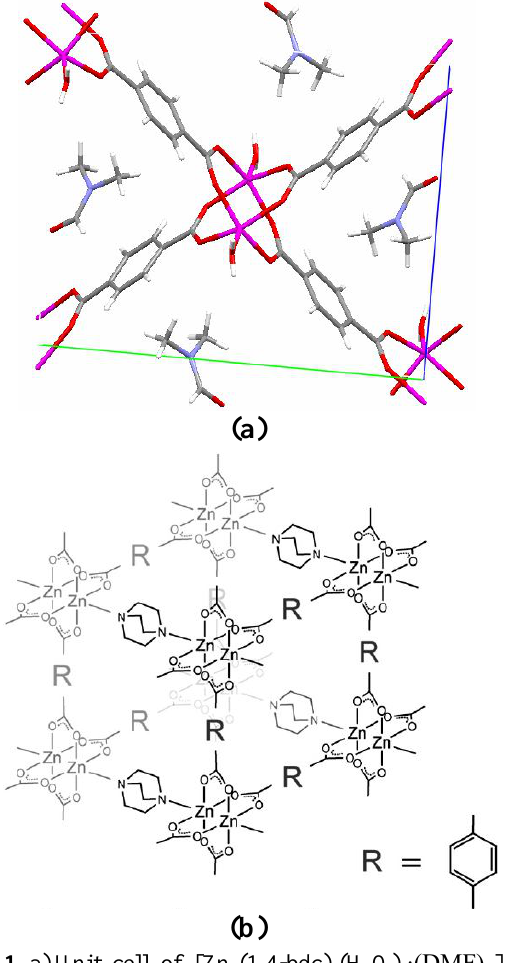
Fig. 1. a) Unit cell of [Zn